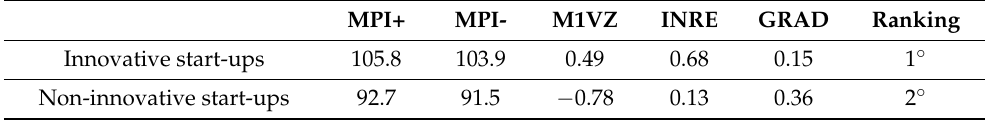
Table 4. SP-score. Comparison of five aggregation methods.